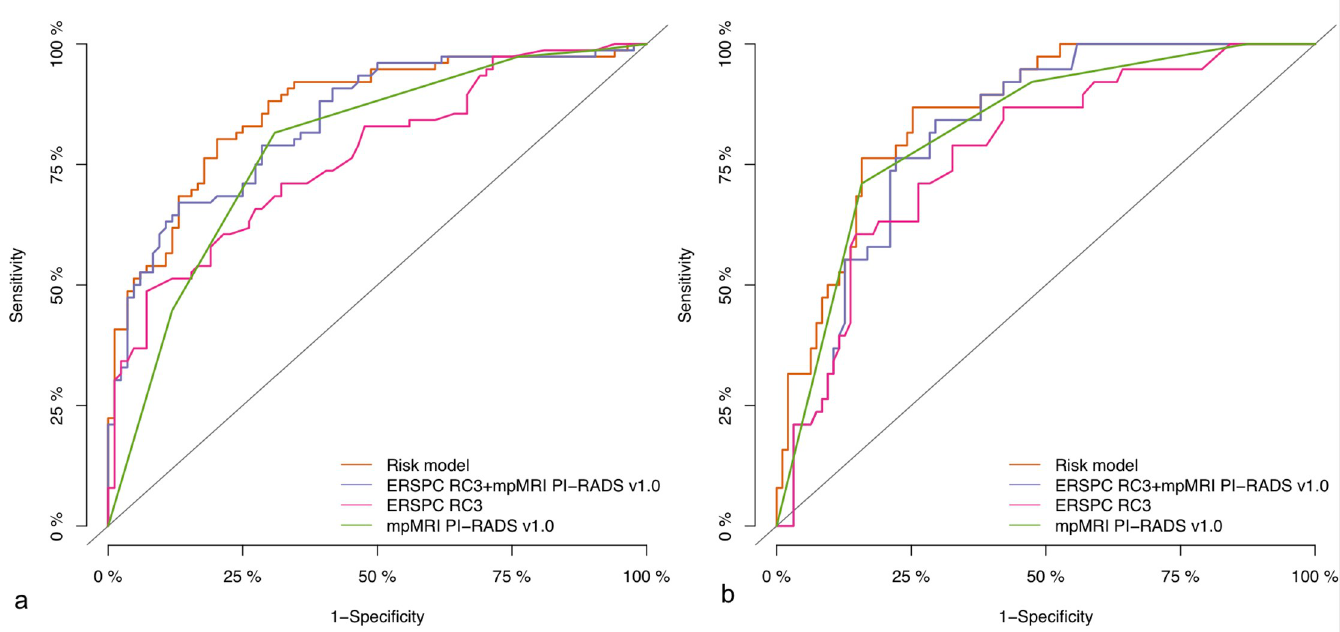
Fig 1. ROC curve analysis for the performance of mpMRI PI-RADSv1.0 (green line), ERSPC-RC3 (pink line), ERSPC-RC3+mpMRI PI-RADSv1.0 (purple line) and the risk model (orange line) to predict sPC for a) Heidelberg validation cohort, b) UCLH validation cohort. AUCs are given in Table 3.